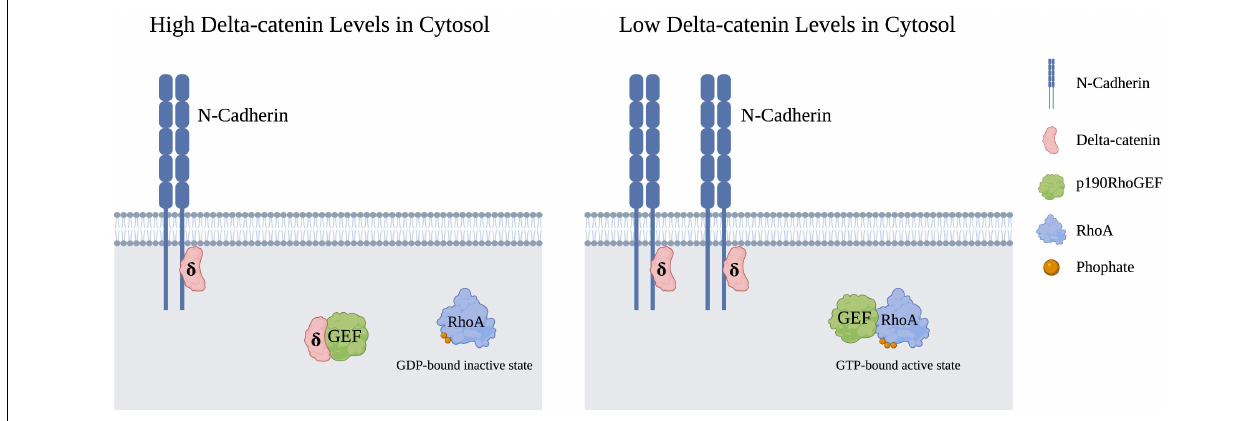
FIGURE 2 | Cytosolic RhoA is inhibited upon the sequestration of p190RhoGEF by cytosolic delta-catenin. An increase in membrane-bound N-cadheren levels in turn lowers delta-catenin presence in the cytosol, such that p190RhoGEF can now transition RhoA from its GDP-bound inactive state to its GTP-bound active state. Created with